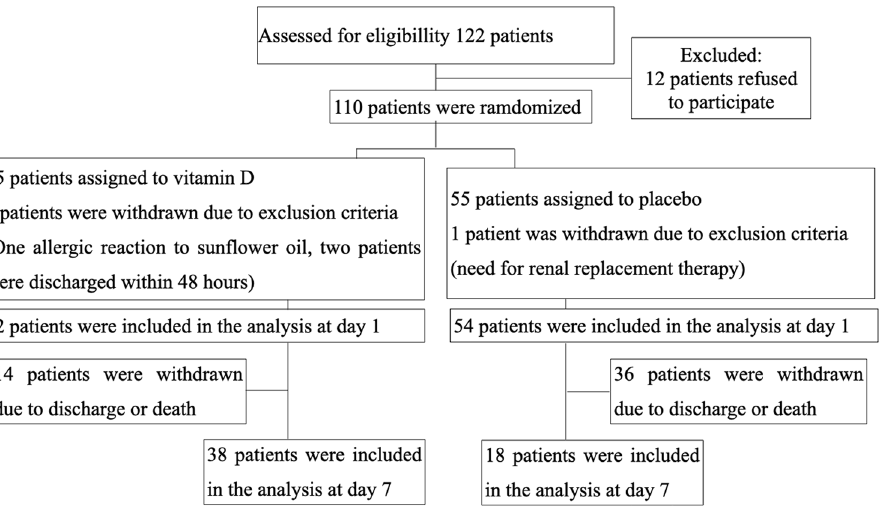
Figure 2. Flow diagram of the COVID-VIT